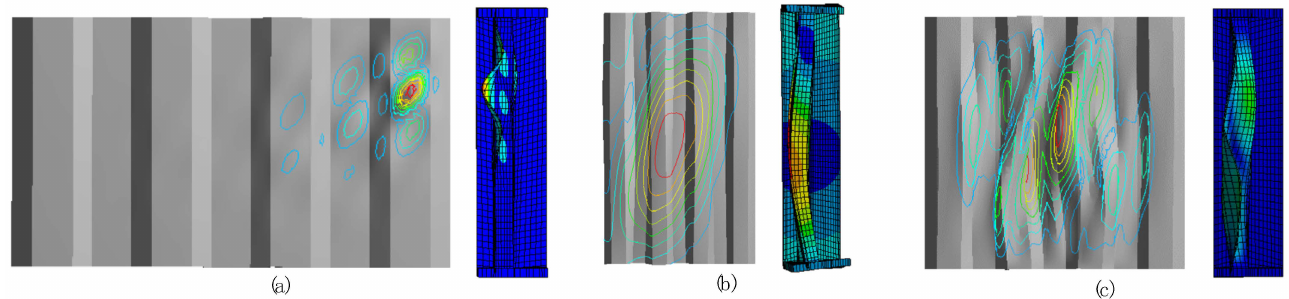
Figure 2. Shear buckling modes: ( a ) local; ( b ) global; and ( c )